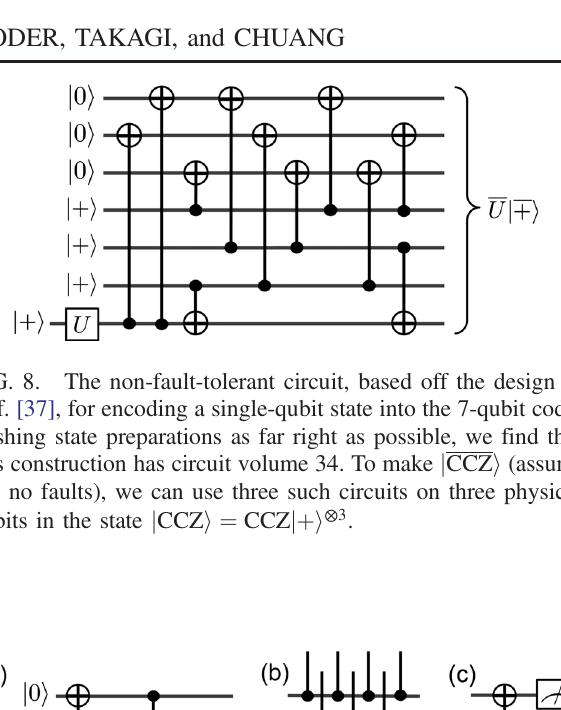
CAT. However, such optimizations are unlikely to erase the nearly 50% improvement (see Table III) that a pieceable CCZ offers. ¯0 i and j ¯ þi are